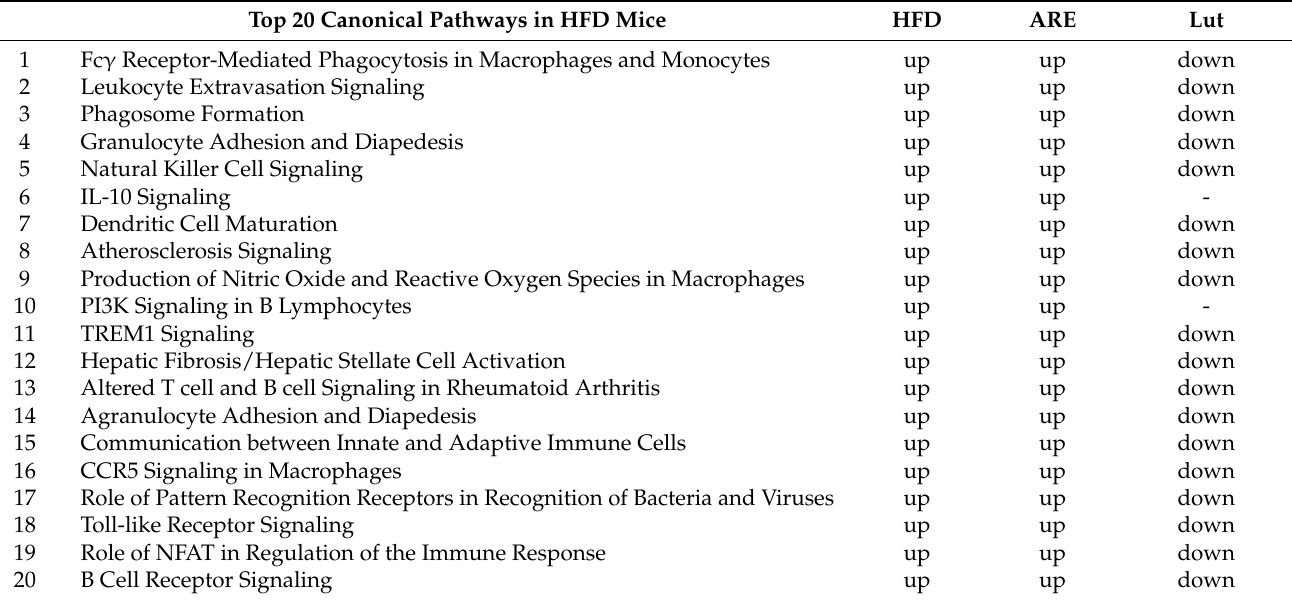
Table 2. Suppressive effects of luteolin treatment on the top 20 altered pathways in high-fat-diet mice. Top 20 Canonical Pathways in HFD